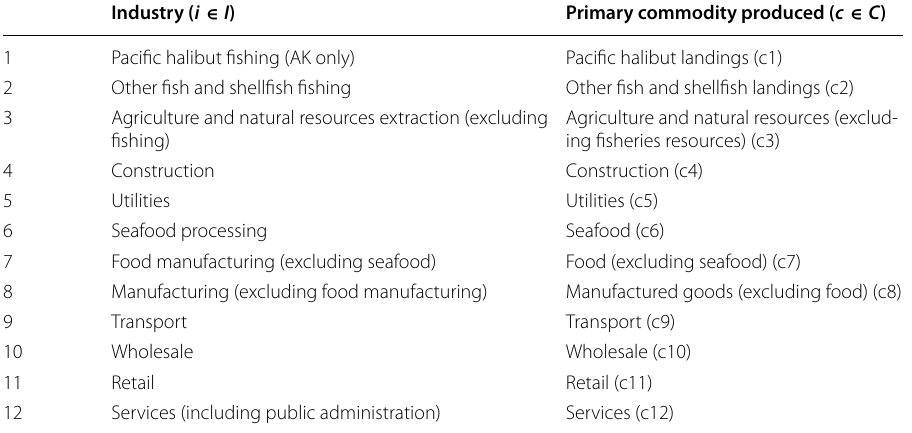
Table 1 Industries and commodities in the